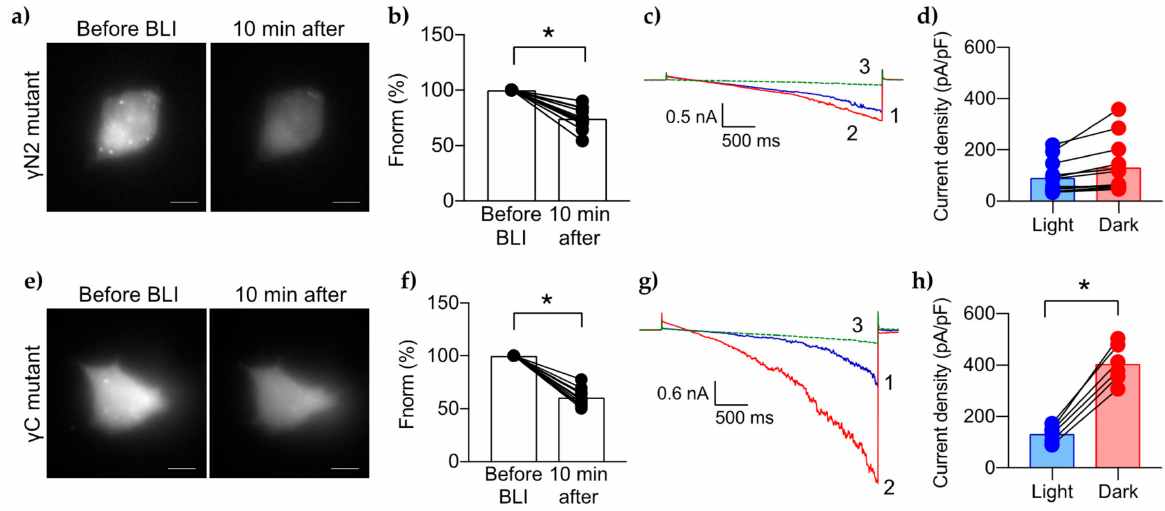
Figure 5. Effects of PIP2 depletion on mutant γ -ENaC. Representative micrographs showing the CoroNa Green fluorescence levels in HEK 293 cells transfected with ENaC containing alanine substi- tutions to the γ N2 site ( a ) or the γ C site ( e ). Summary graphs ( b , f ) of changes in the mean [Na + ] i as determined by CoroNa Green fluorescence levels. Representative current traces of the γ N2 mutant ( c ) or the γ C mutant ( g ) under BLI (1, blue trace), then dark (2, red trace), then 10 µ M amiloride (3, green trace). Summary graphs of the mean current density for the γ N2 mutant ( d ) or the γ C mutant ( h ) at − 100 mV under low PIP2 levels (“Light”, blue bar and blue circles) vs. maximum PIP2 levels (“Dark”, red bar and red circles). *, p < 0.0001 determined by paired t